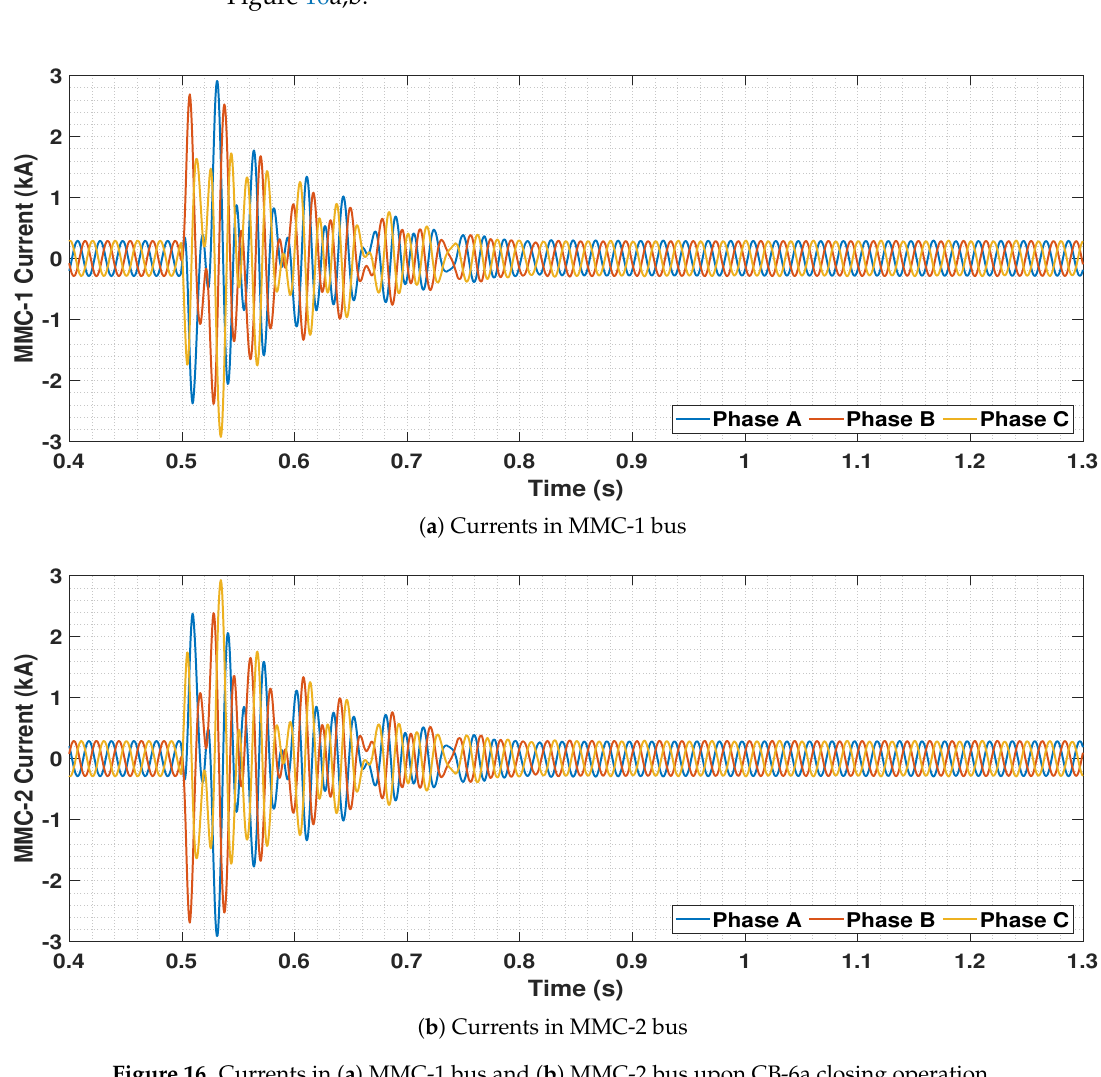
Figure 16. Currents in ( a ) MMC-1 bus and ( b ) MMC-2 bus upon CB-6a closing